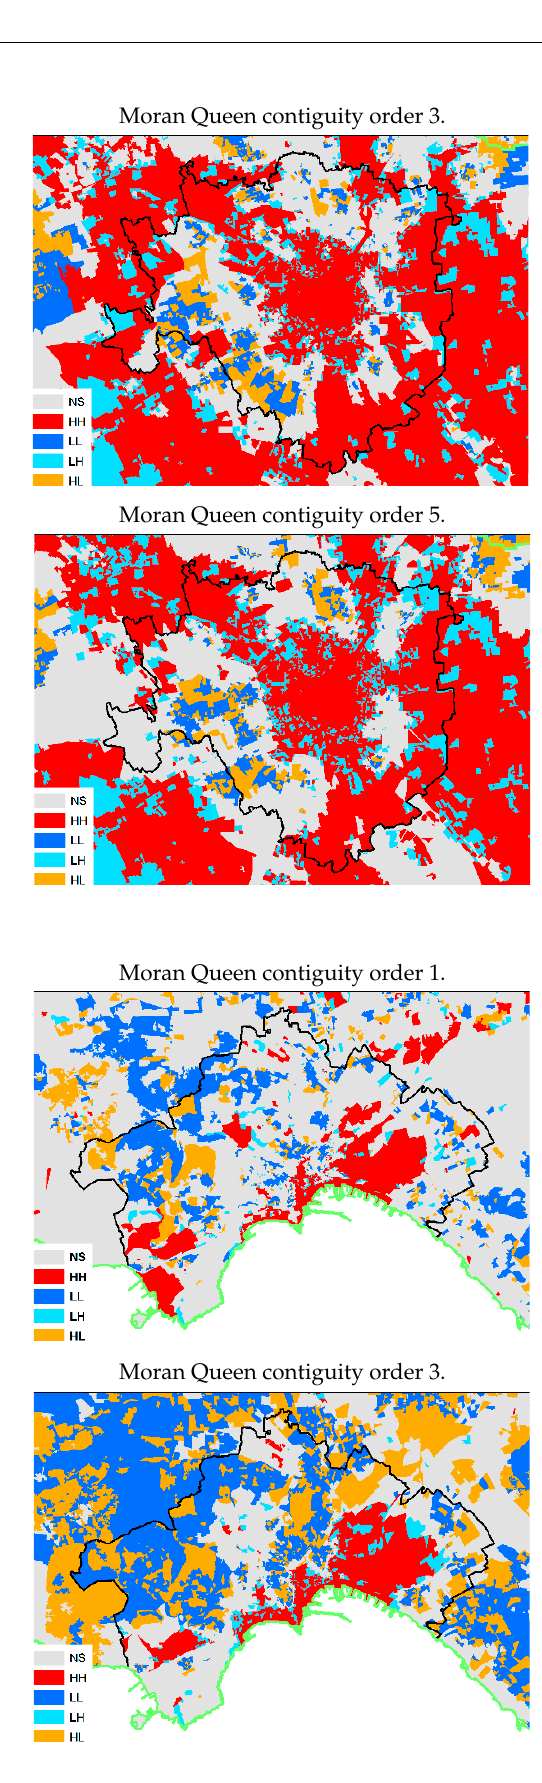
Moran Queen contiguity order